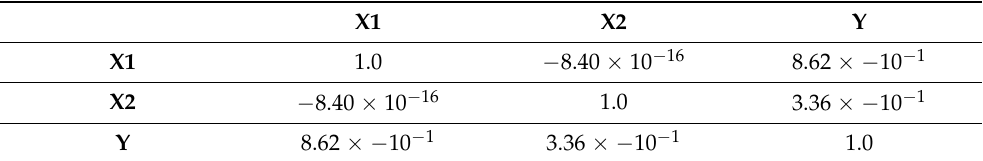
Table 3. Pearson correlation analysis of